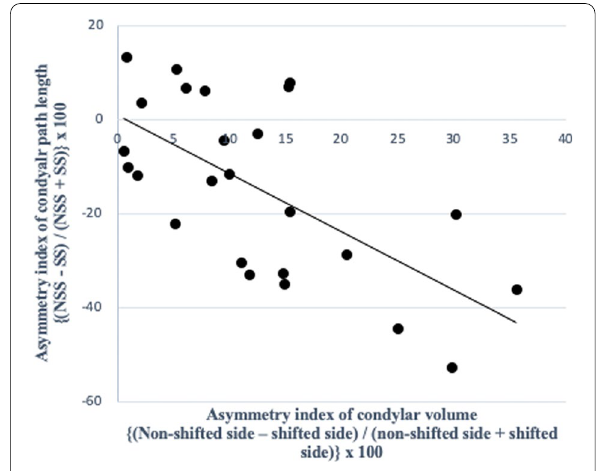
Fig. 5 Simple regression analysis of the asymmetry index of the condylar volume and the condylar path length in the mandibular asymmetry group. X ‑axis, asymmetry index of the condylar volume; Y ‑axis, asymmetry index of the condylar path